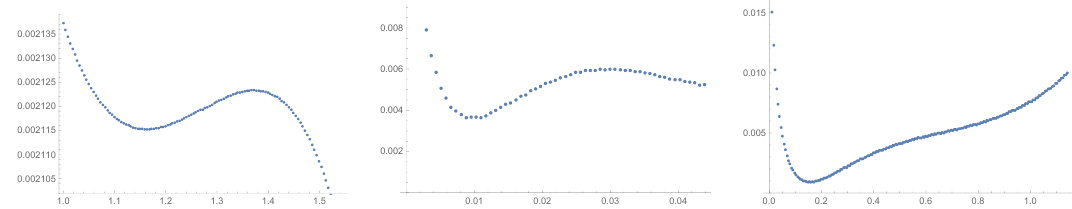
(cid:16) (cid:17) A (cid:48) ( β ) − Avg ( α ) , β , β 2 2